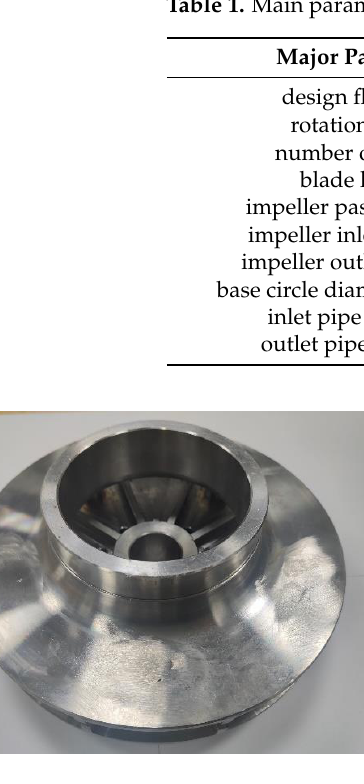
Figure 1. Disc impeller material object and 3D Model of it. Table 1. Main parameters of disc pump with Radial Straight Blade.